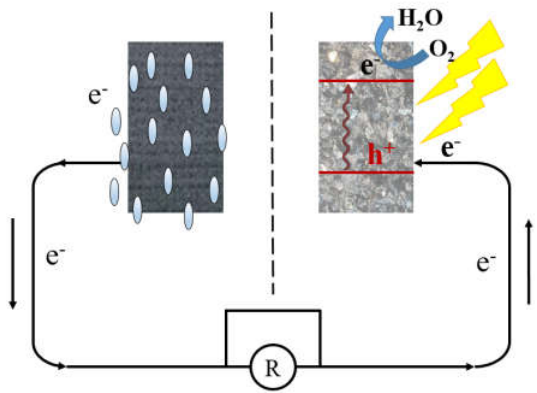
Figure 7. Schematic representation of the enhanced performance of an MFC with a wolframite photocatalyst.